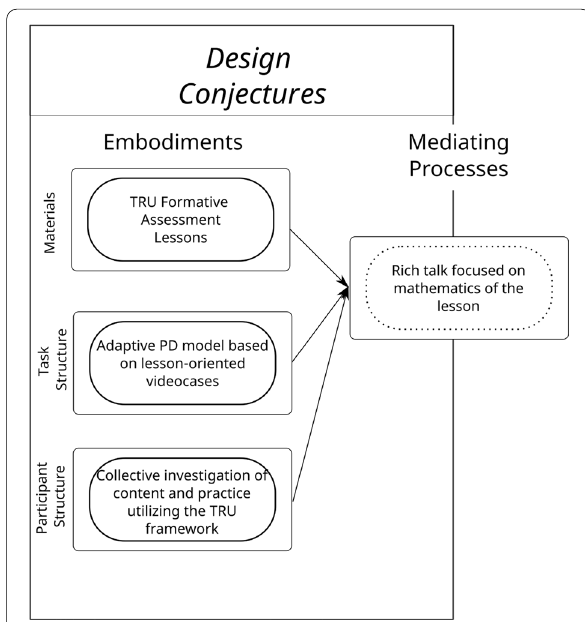
Fig. 3 Elements of the conjecture map that show up in the first activity structure. The dashed lines indicate an element coding targeted for